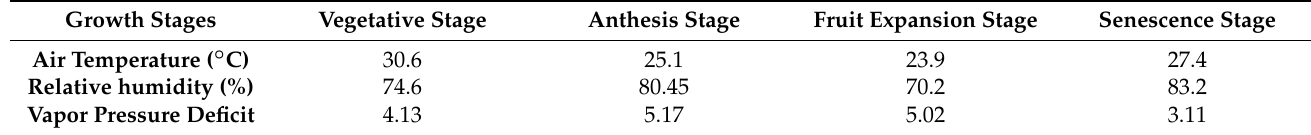
Table 3. Weather conditions at each growth